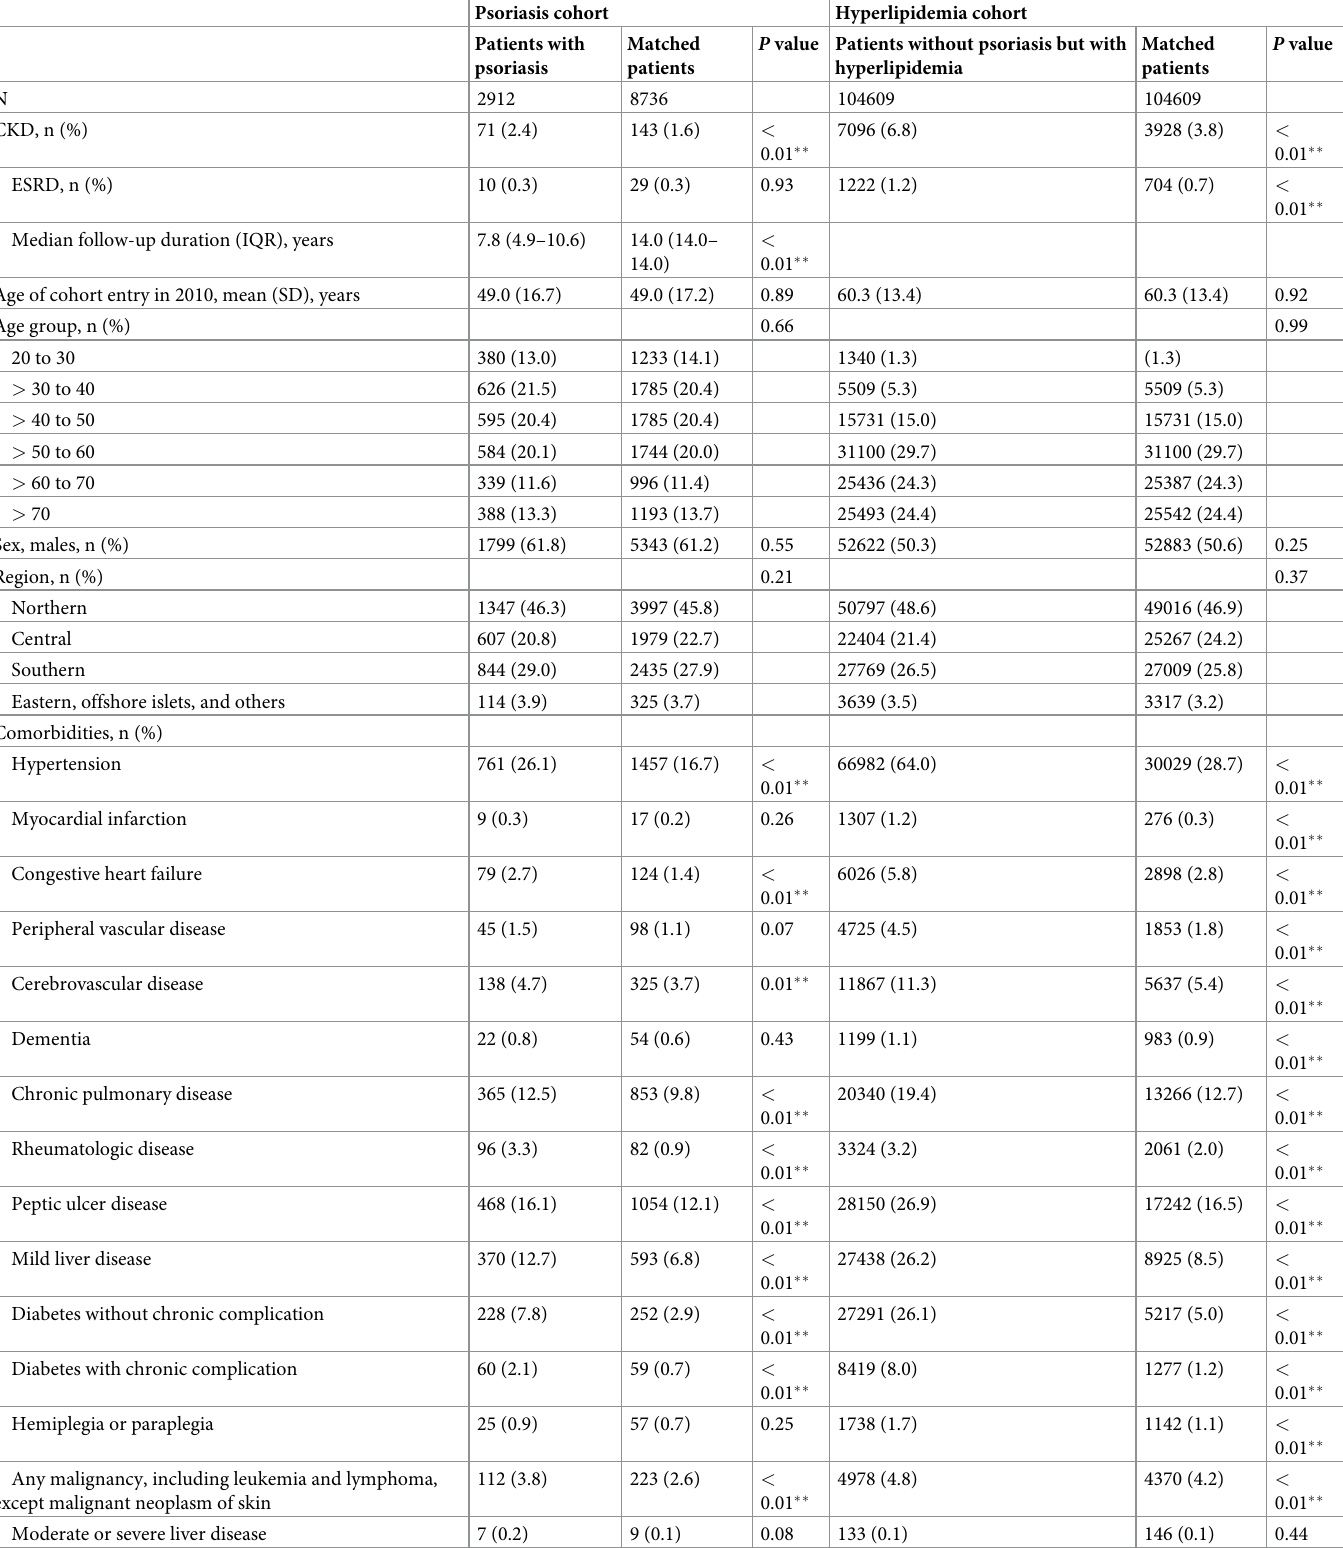
Table 1. Characteristics of study and matched